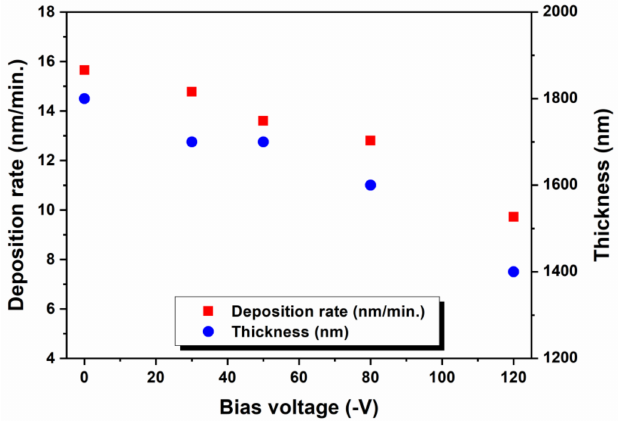
Figure 2. Deposition rate and thickness of the Ta films deposited by DOMS as a function of the bias